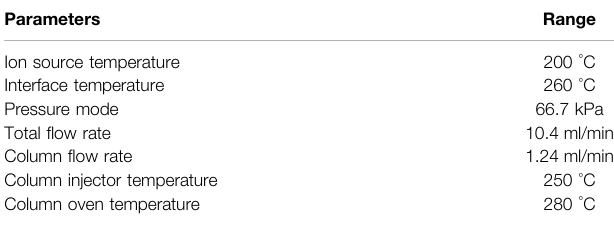
TABLE 1 | Parameters used during GC-MS